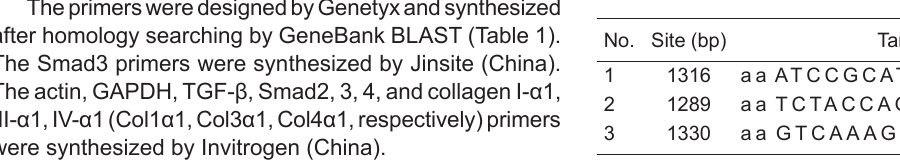
Table 2. Three target sites for smad3